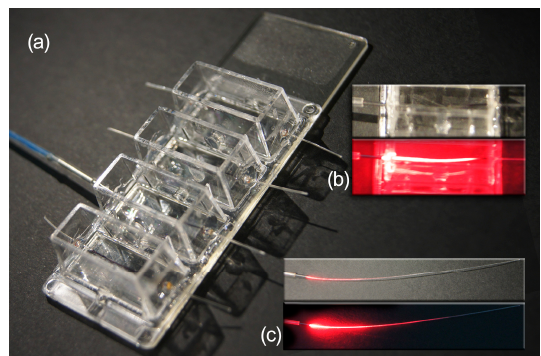
Figure 4. ( a ) Cell culture chambers set-up used for the red laser irradiation experiments; ( b ) Details of the RL light ( λ = 650 nm) diffusion from the free-standing SGF 5 at ambient light and in darkness; ( c ) Details of the RL light diffusion from the SGF 5 inserted in the cell culture chamber at ambient light and in darkness.